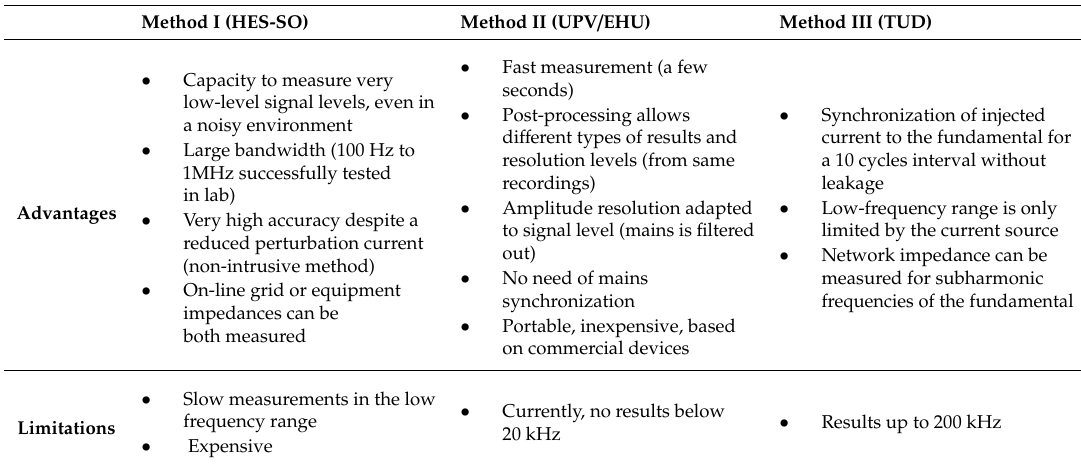
Table 2. Summary of the advantages and limitations of the measurement